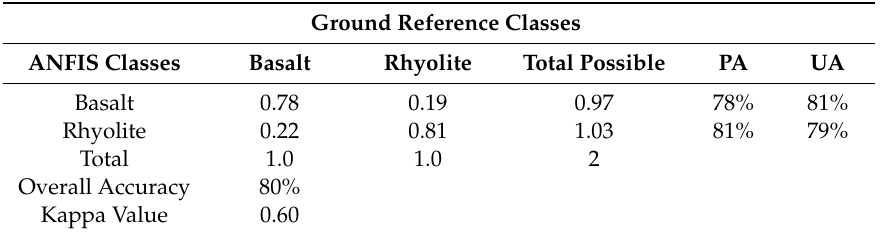
Table 1. Normalized accuracy assessment. PA: producer’s accuracy, UA: user’s accuracy.